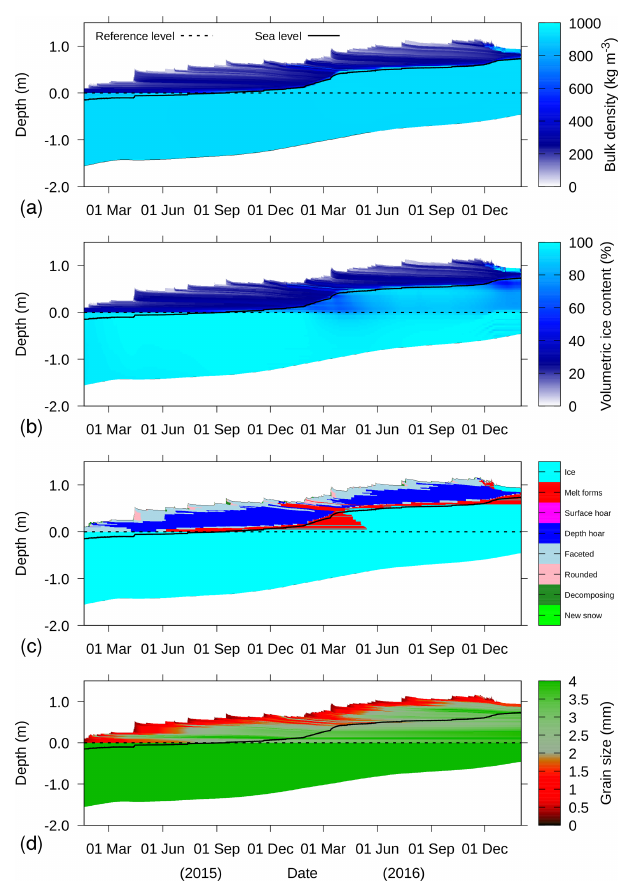
Figure 9. Example simulation for buoy 2014S12, where measured snow depth was used to derive the precipitation events, for (a) total bulk density, (b) volumetric ice content, (c) grain type, and (d) grain size. The depth on the y axis is defined relative to the snow–ice interface, as determined upon installation (dashed line). The solid line denotes the sea level as determined by the